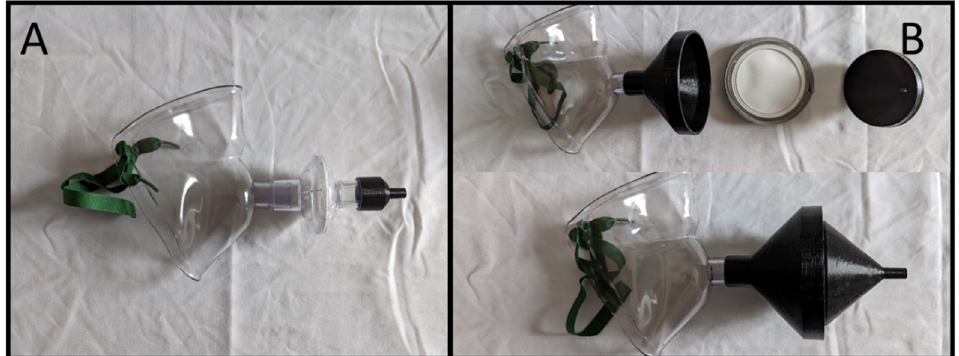
Figure 1. Images and designs of IACM components. ( A ) Assembled IAMC device using a viral filter. Suction can be attached at the end of the custom adaptor (right). ( B ) IACM device used to collect respiratory particles for analysis. This version used a water-soluble 80 mm gelatin filter to collect particles for easy recovery. In addition, sterile gauze was used to swab the interior surface of the clear mask to recover deposited particulate. Detailed designs of the custom filter housing used to attach 80 mm filter to mask and suction, and the custom adaptor used to connect viral filter to suction tubing are available in the Supplementary Materials (Figures S1 and S2).